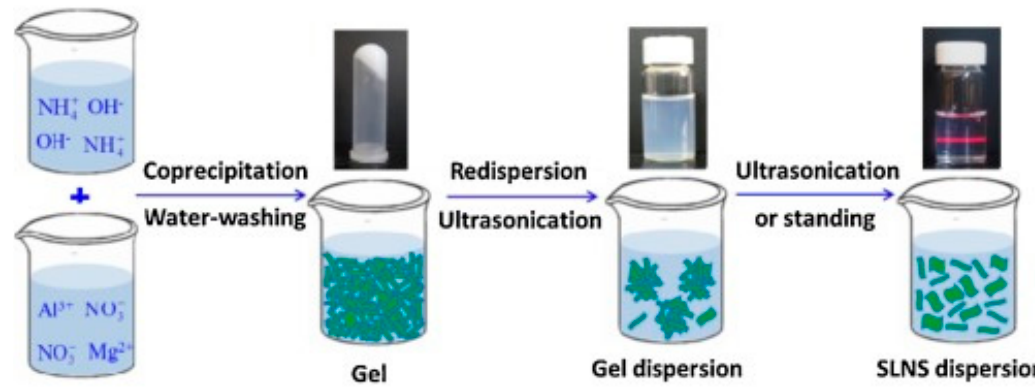
Figure 9. Schematic representation of sol-gel method of layered double hydroxide (LDH). Reproduced with permission from Reference [77]. Copyrights 2016, Elsevier.